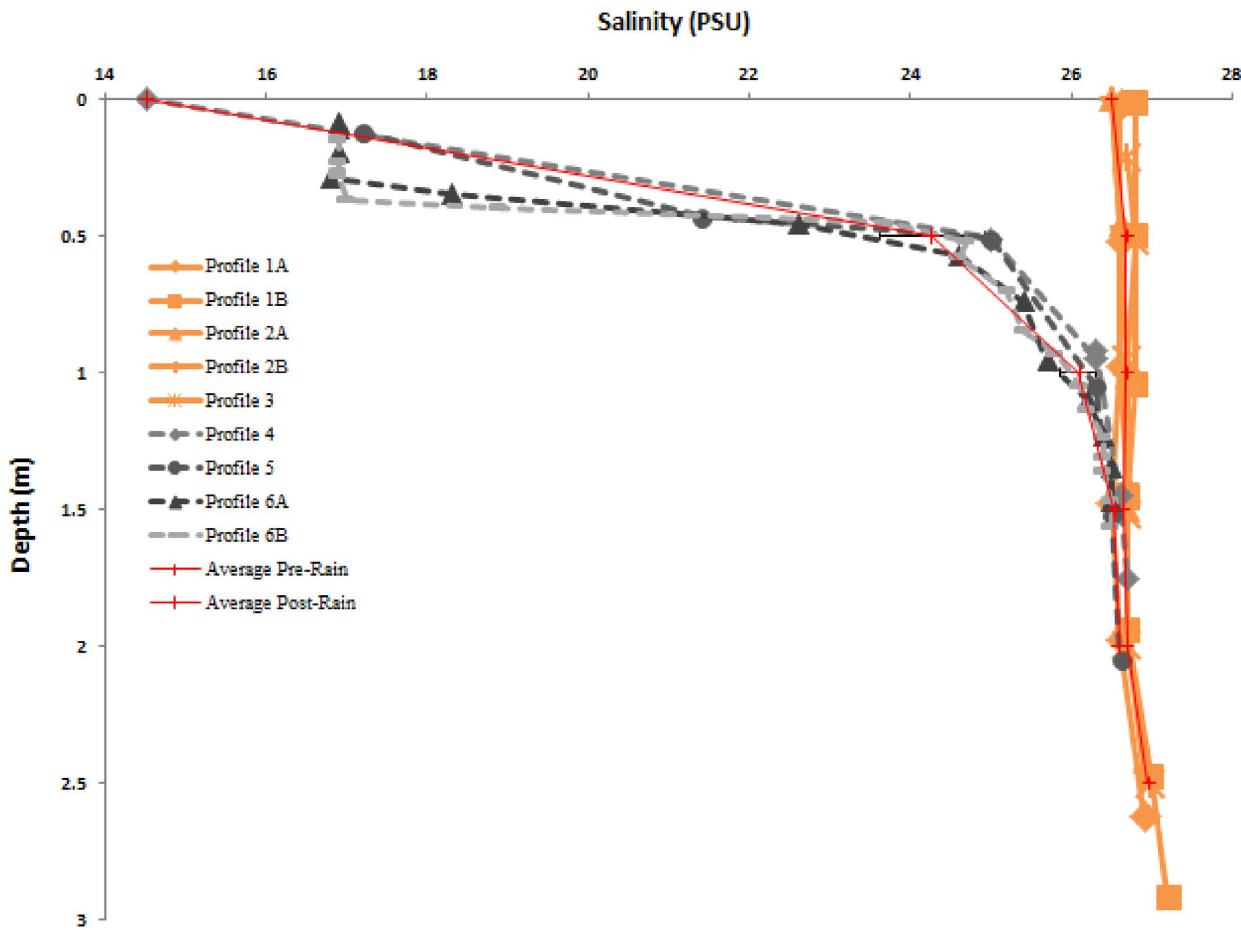
Figure 3. Salinity Profiles. Depth profiles of measured salinity, July 21–23, prior to significant rain event (in orange), with July 24–25, following a significant rain event (in gray scale). In the top meter of Lib Pond, there was a dramatic decrease in salinity following a series of freshwater precipitation events (Table 2, July 23–24). Also displayed are pre-rain and post rain averages with horizontal errors bars representing the standard deviation of the average, on either